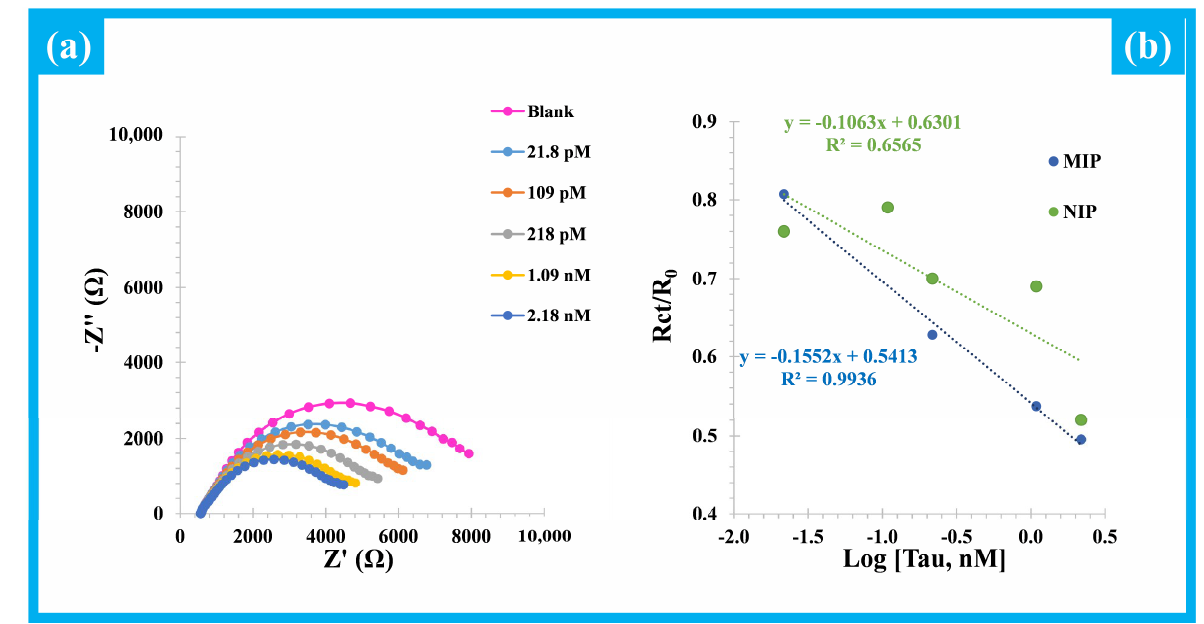
Figure 6. EIS measurements of ( a ) MIPs based biosensor and the corresponding calibration curves ( b ) in 5.0 mM [Fe(CN) 6 ] 3 − and 5.0 mM [Fe(CN) 6 ] 4 − by spiking Tau protein in serum. Table 1. Biosensors to detect Tau